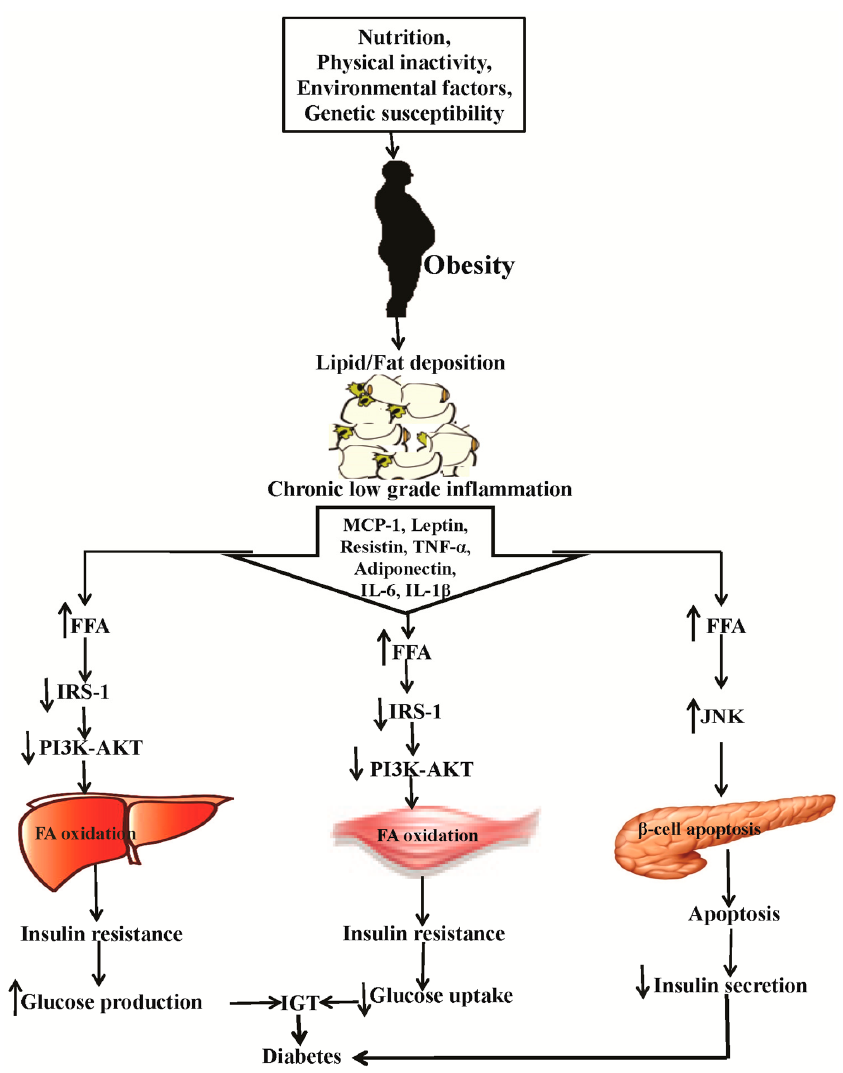
Figure 1. Schematic diagram of the link between obesity and diabetes as well as their effects in skeletal muscle, liver, and pancreas for stimulating different inflammatory cytokines, metabolic enzymes, and signaling pathways. Nutrition, physical inactivity, environmental factors, and genetic susceptibility cause obesity and fat deposition that initiates chronic low-grade inflammation to release MCP-1, leptin, resistin, TNF- α , adiponectin, IL-6, and IL-1 β . Chronic inflammation leads to increased secretion of FFA from the liver, skeletal muscles, and pancreas. Increased FFA reduces the expression of IRS-1 and PI3K-AKT in the liver and skeletal muscles and increased JNK expression in the pancreas, ultimately causing insulin resistance in the liver and muscle and increasing apoptosis in the pancreas. Insulin resistance causes glucose production increase and glucose uptake decrease, and insulin secretion decreases because of increased apoptosis of pancreatic β cells. MCP-1: monocyte-chemo-attractant protein-1 [19]; TNF- α : tumor necrosis factor α [21]; IL-6: interleukin-6 [19]; IL-1 β : interleukin 1 β [19]; FFA: free fatty acid [23]; IRS1: insulin receptor substrate 1 [24,25]; PI3K: phosphatidylinositol 3-kinase [24,25]; AKT: serine/threonine kinase [24,25]; JNK: c-Jun N-terminal kinase [26] FA: fatty acid [23]; IGT: impaired glucose tolerance [23]. ( Ó ) Decrease, ( Ò )